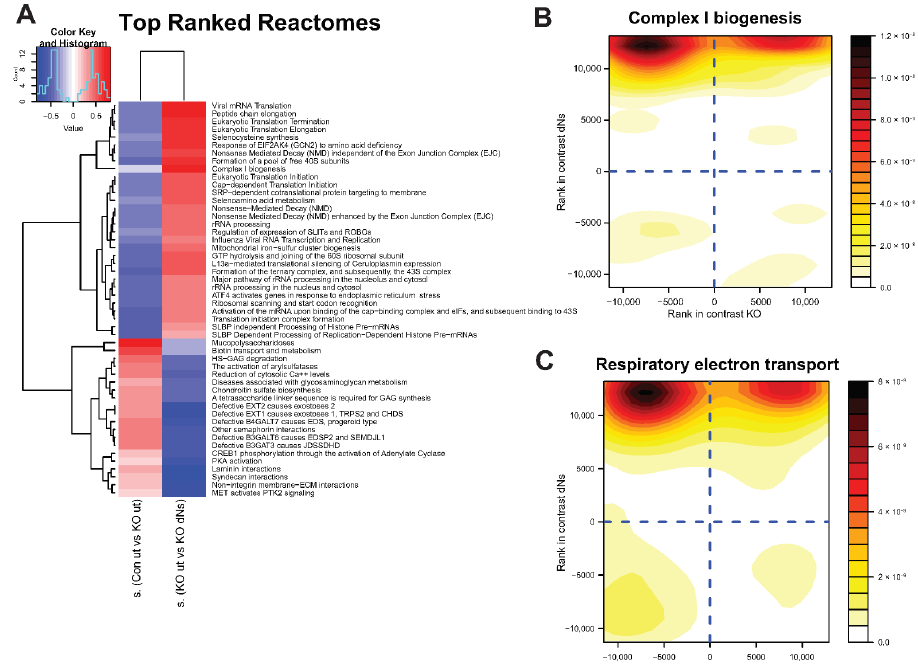
Figure 3. dNs stimulate genes involved in complex I biogenesis and respiratory electron transport in ECHS1 KO cells. ( A ) Heat map showing enrichment scores of gene sets selected by discordance between comparison of untreated control cells (CON ut) and untreated ECHS1 KO (ut) cells (left column), with comparison of untreated ECHS1 KO cells (ut) and dNs treated ECHS1 KO cells (dNs) (right column), as ranked by effect size (s.dist). Blue indicates gene sets that are downregulated, red indicates gene sets that are upregulated. Complex I biogenesis is a key gene set that was downreg- ulated in ECHS1 KO cells (blue, left column) but increased following dNs treatment (red, right col- umn). ( B ) Contour density plot showing discordant regulation of gene set members of complex I biogenesis. X axis shows rank in comparison between untreated ECHS1 KO cells and untreated CON cells, Y axis shows rank in comparison between untreated and dNs treated ECHS1 KO cells. Shading represents density of genes within section of graph. Darker colours indicate higher inten- sity. ( C ) Contour density plot showing discordant regulation of gene set members of respiratory electron transport. X axis shows rank in comparison between untreated ECHS1 KO cells and un- treated CON cells, Y axis shows rank in comparison between untreated or dNs treated ECHS1 KO cells. Shading represents density of genes within section of graph. Darker colours indicate higher intensity. Conversely, untreated ECHS1 KO cells have downregulated ‘complex I biogenesis’ ( − 0.12 s.dist) , ‘selenoamino acid metabolism’ ( − 0.34 s.dist) , and ‘mitochondrial iron -sulfur cluster biogenesis’ ( − 0.44 s.dist) compared to untreated CON cells (Figure 3A left column, shaded blue), yet these gene sets were upregulated in ECHS1 KO cells following dNs